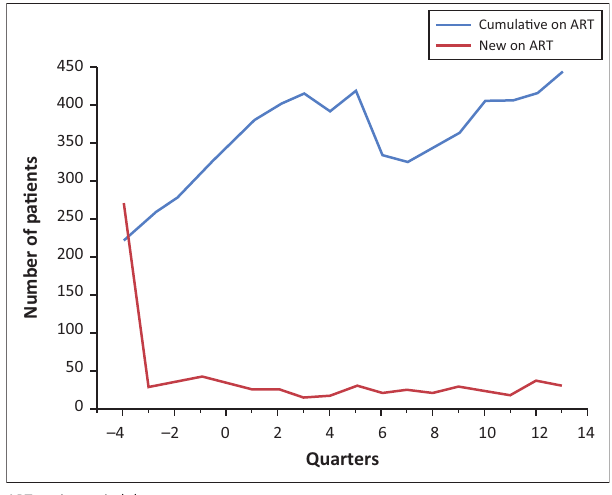
Cumula(cid:26)ve on ART New on ART